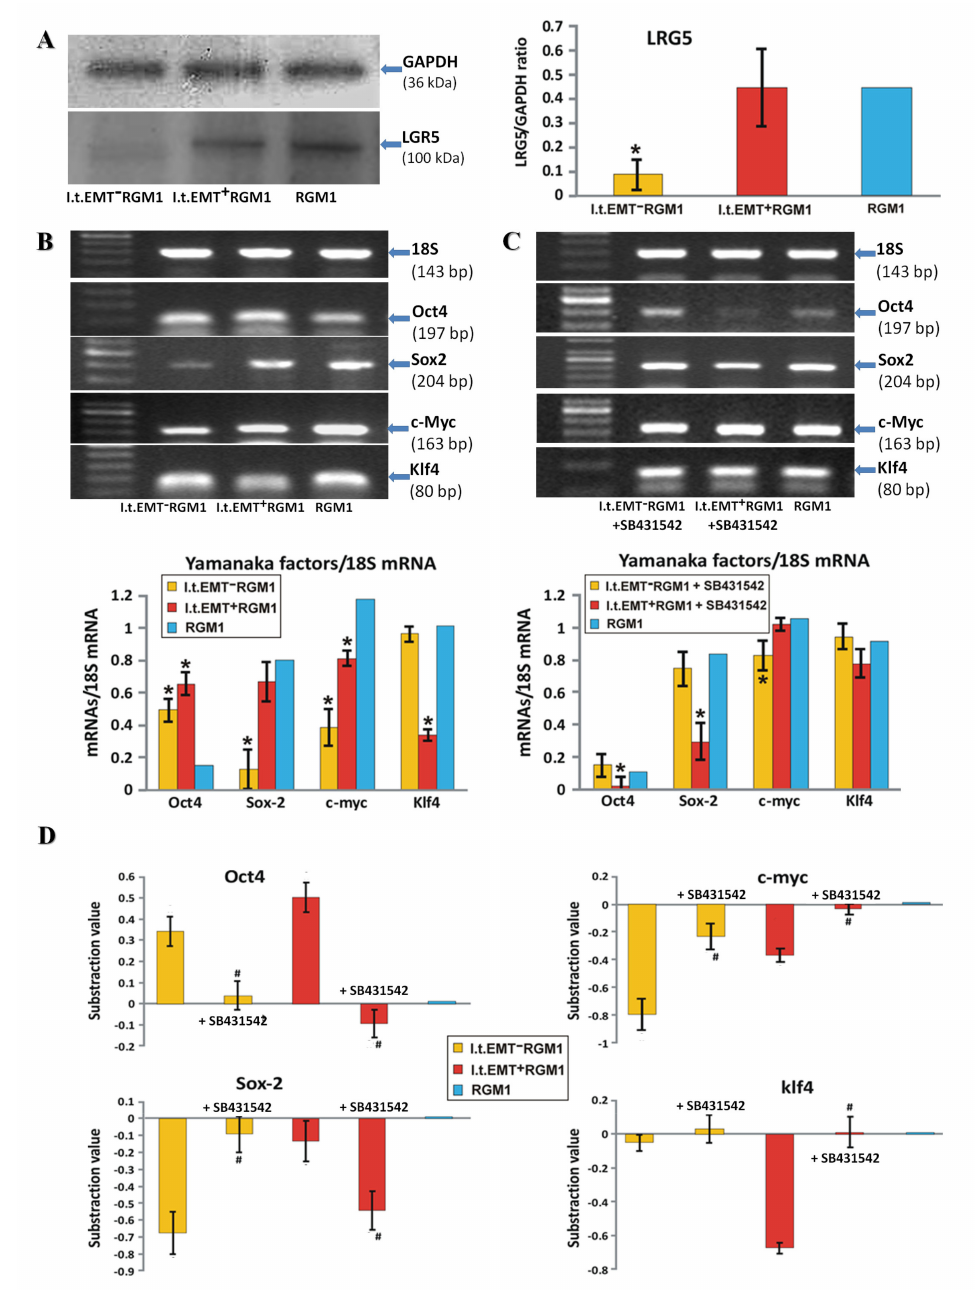
Figure 3. TGF β R1 participates in both pro-pluripotent and pro-fibrotic RGM1 reprogramming. ( A ) Western blot analysis of LGR5 in total cellular proteins isolated from l.t.EMT − RGM1 cells, l.t.EMT + RGM1 cells, and original RGM1 cells and semi-quantitative densitometry analysis of the ratio of selected proteins over GAPDH. The 10 µ g of total cellular proteins were loaded per each lane. ( B ) RT-PCR analysis of the expression of 18S mRNA and pluripotency indicators Yamanaka factors in l.t.EMT − RGM1 cells, l.t.EMT + RGM1 cells, and original RGM1 cells and the ratio of selected genes over 18S mRNA. ( C ) RT-PCR analysis of expression of 18S mRNA and TGF β R1 signaling dependence of pluripotency indicators Yamanaka factors’ mRNA expression in l.t.EMT − RGM1 cells, l.t.EMT + RGM1 cells, and original RGM1 cells after addition of TGF β R1 kinase activity receptor inhibitor SB-431542